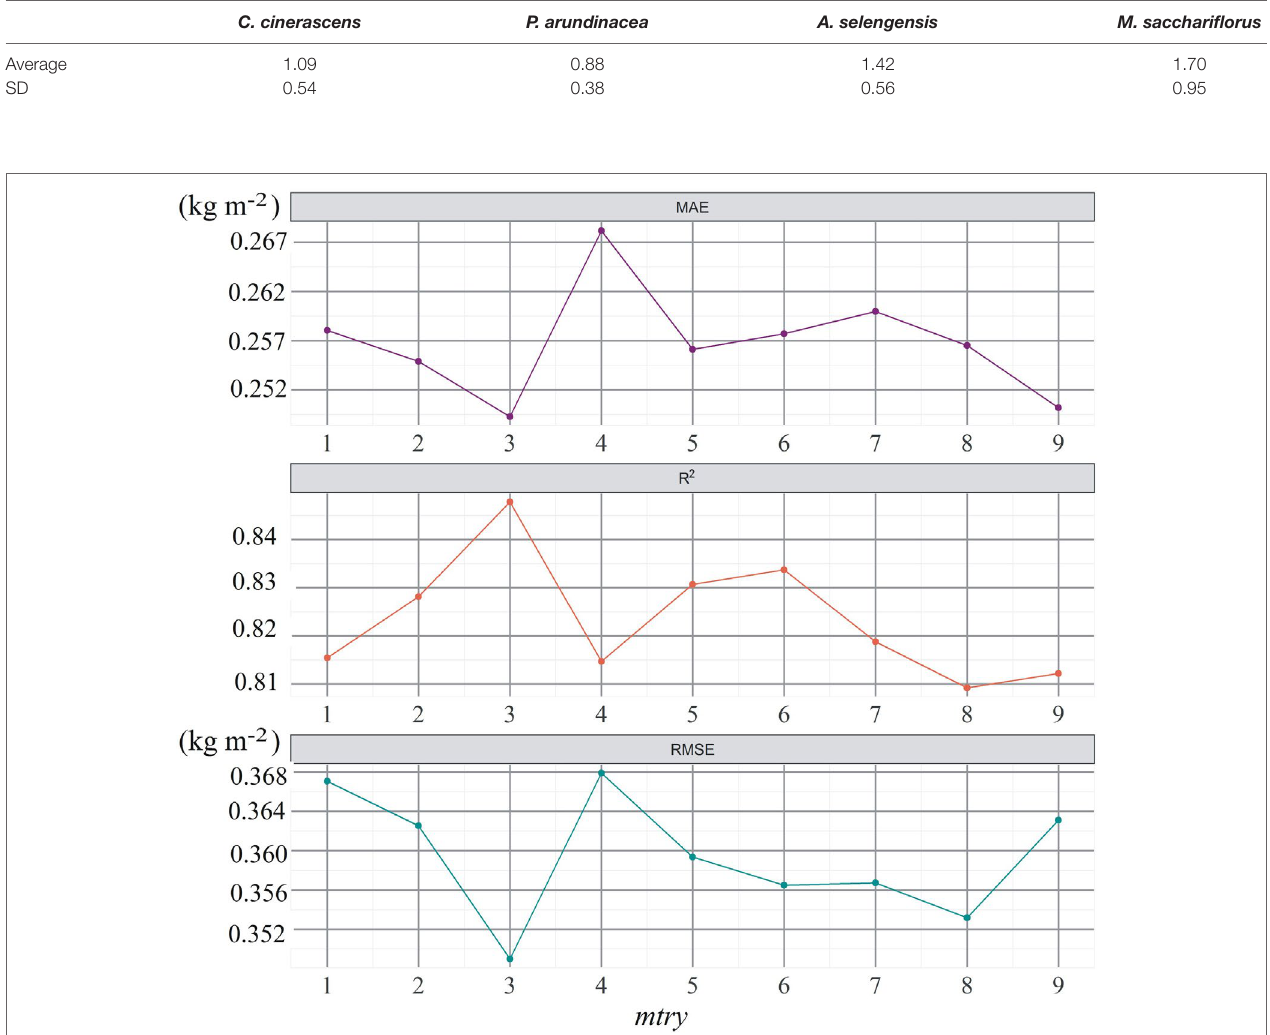
FIGURE 5 | Prediction accuracy of the RF model on training data set when mtry varies from 1 to